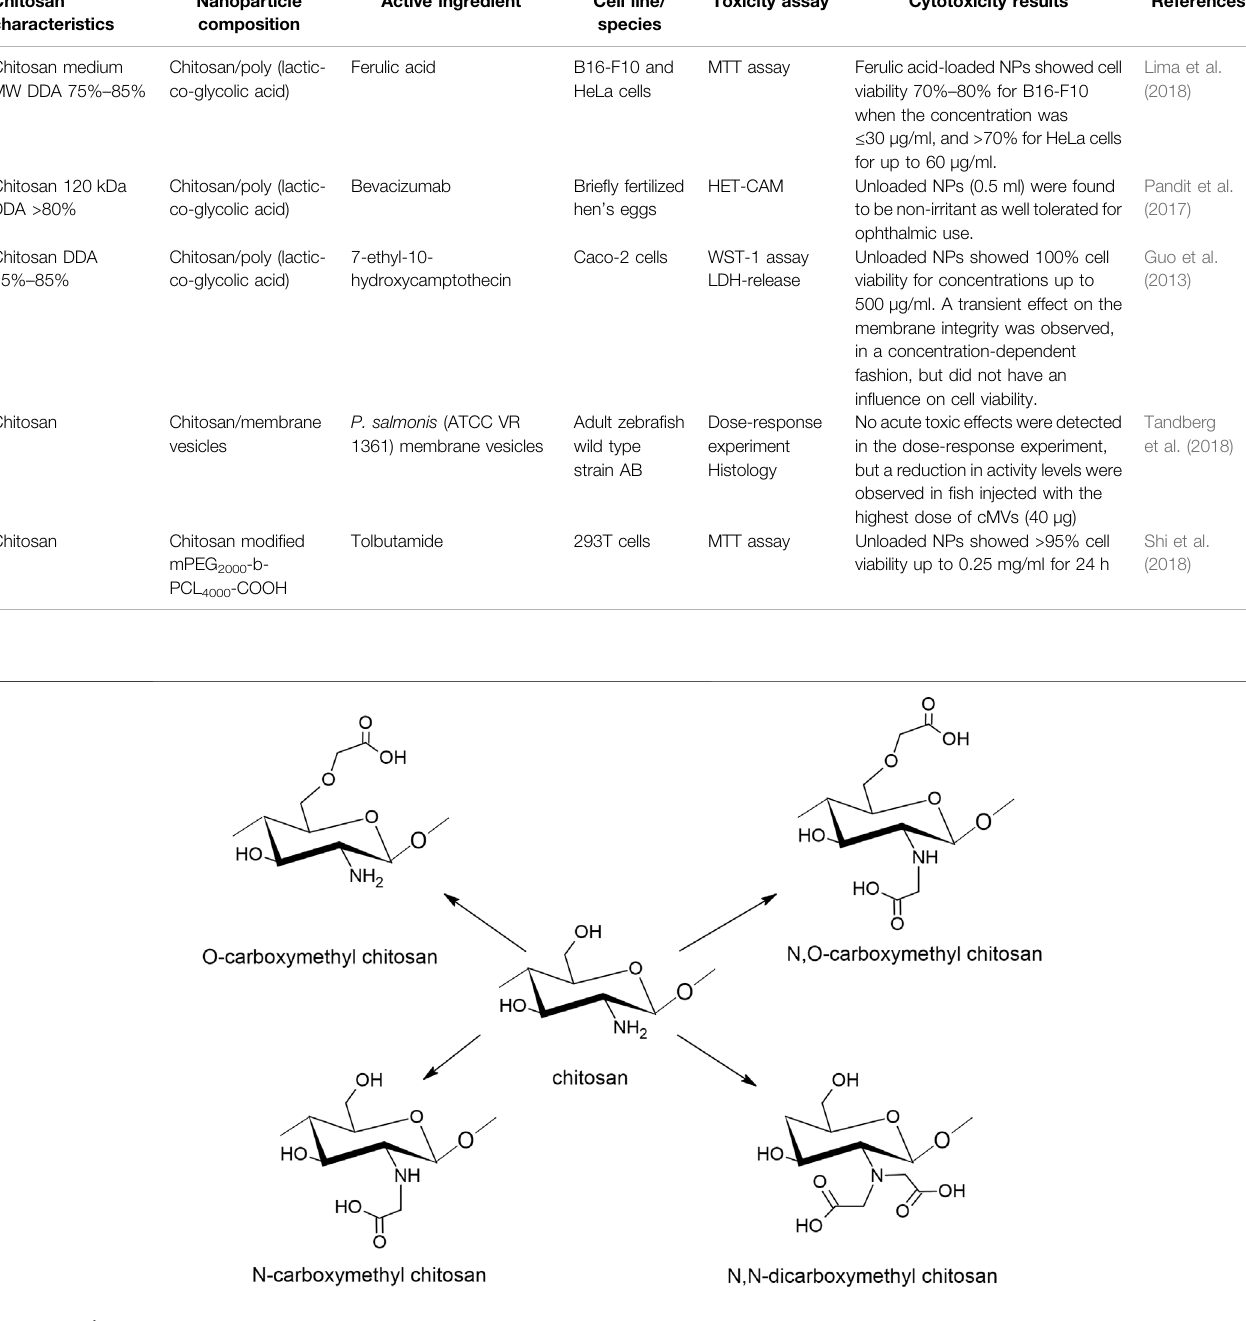
FIGURE 4 | Schematic representation of carboxymethylated chitosan and its derivatives.